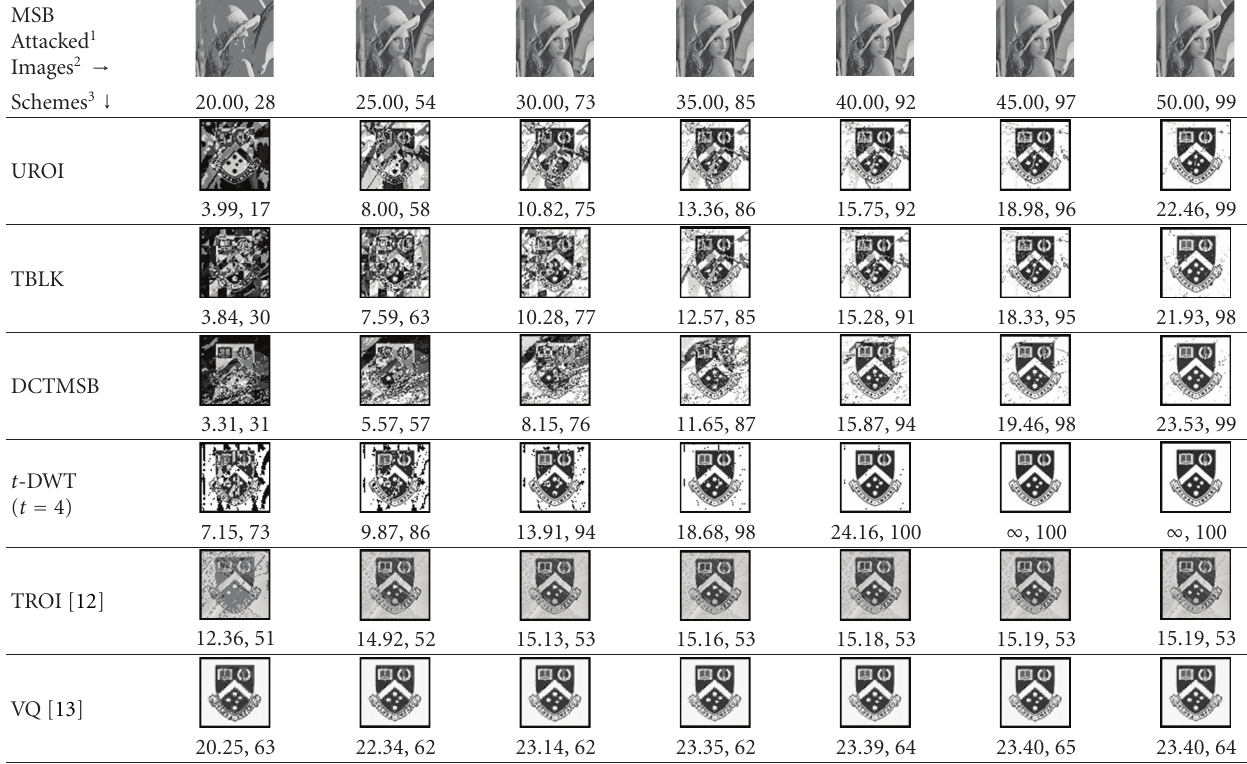
Table 7: MSB attacked images along with their corresponding retrieved logos using Lena image and Monash logo by di ff erent approaches of the proposed MSB-based scheme and existing TROI-based [12] and VQ-based [13]